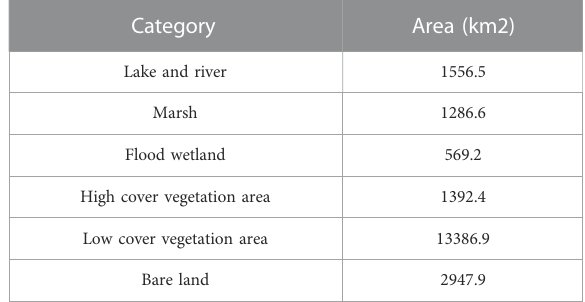
TABLE 6 Statistics of land cover type area at the HAYR.